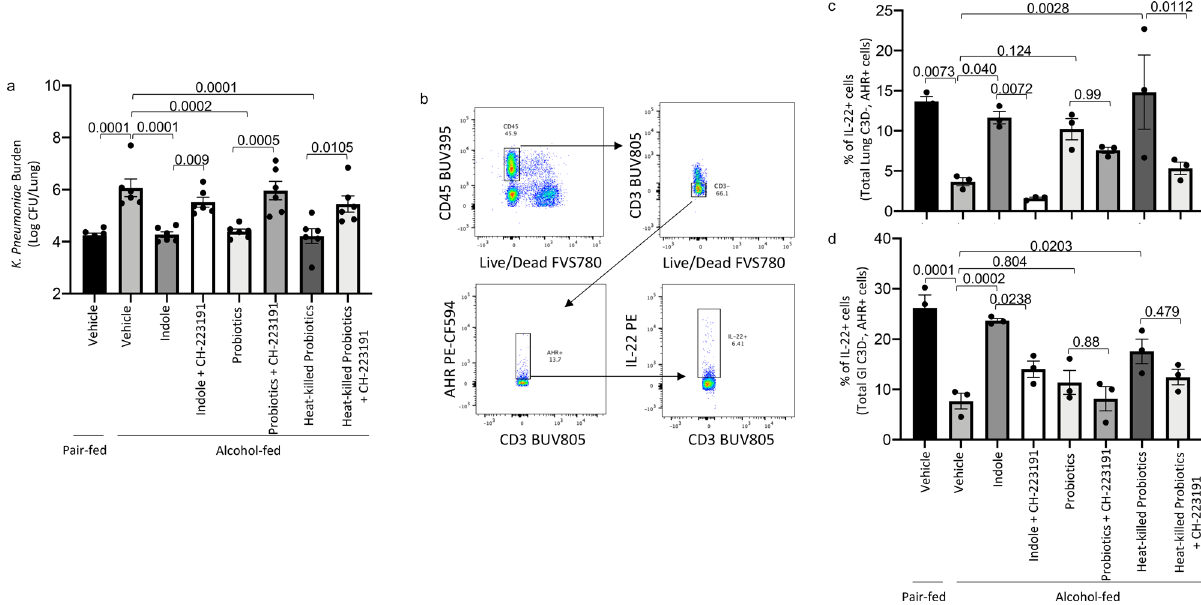
Fig. 5 Indole and probiotics treatment increase the frequency of IL-22 + immune cells in the lungs and small intestine. Binge-on-chronic alcohol-fed mice with and without treatment were infected with Klebsiella and sacri fi ced 48 h post-infection. a Klebsiella lung burden (Log CFU/ml). b Flow cytometry gating strategy. c Percent of pulmonary IL-22 + immune cells (CD3 − AhR + ) in binge-on-chronic alcohol-fed mice with and without treatment infected with Klebsiella. d Percent of intestinal IL-22 + immune cells (CD3 − AhR + ) in binge-on-chronic alcohol-fed mice with and without treatment infected with Klebsiella . Bars represent the mean ± SEM and dots represent individual mice. P values are indicated in the fi gure, as determined by one ‐ way ANOVA with Sidak ’ s multiple comparison test. N = 3 –